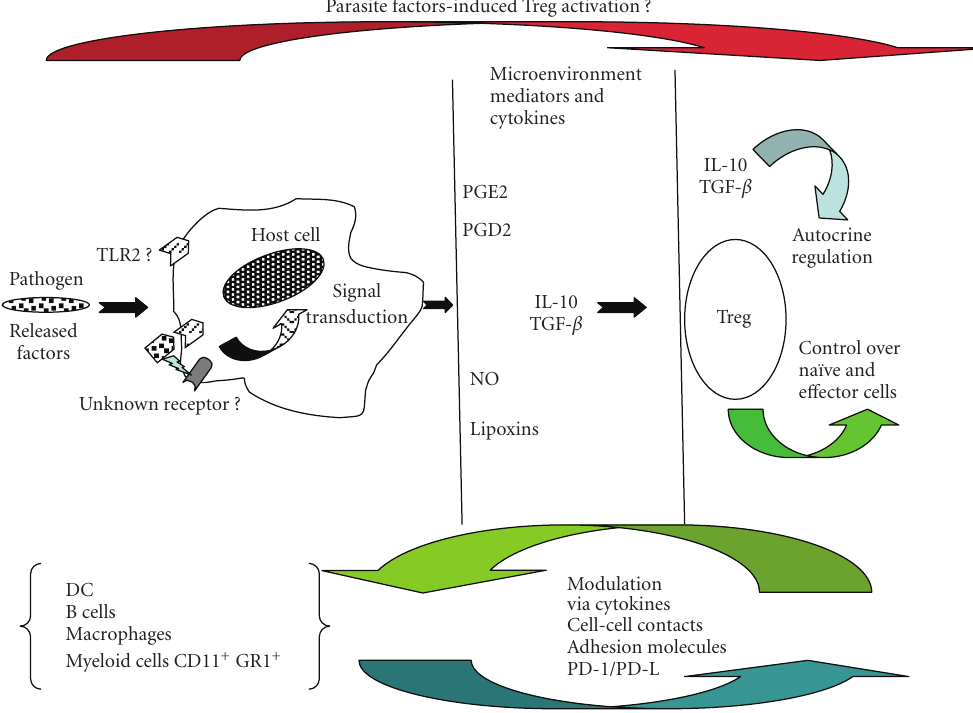
Figure 1: A model for parasite-derived factors-host cell interaction and signaling